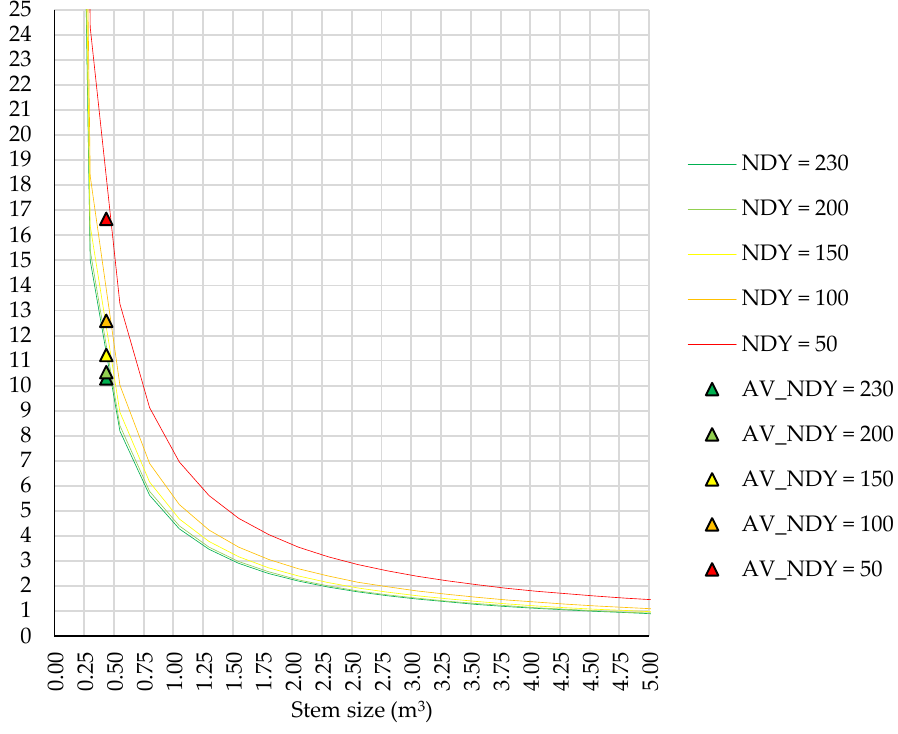
Figure 6. Operational cost as a function of stem size. Note: NDY—cost figures based on the simulated